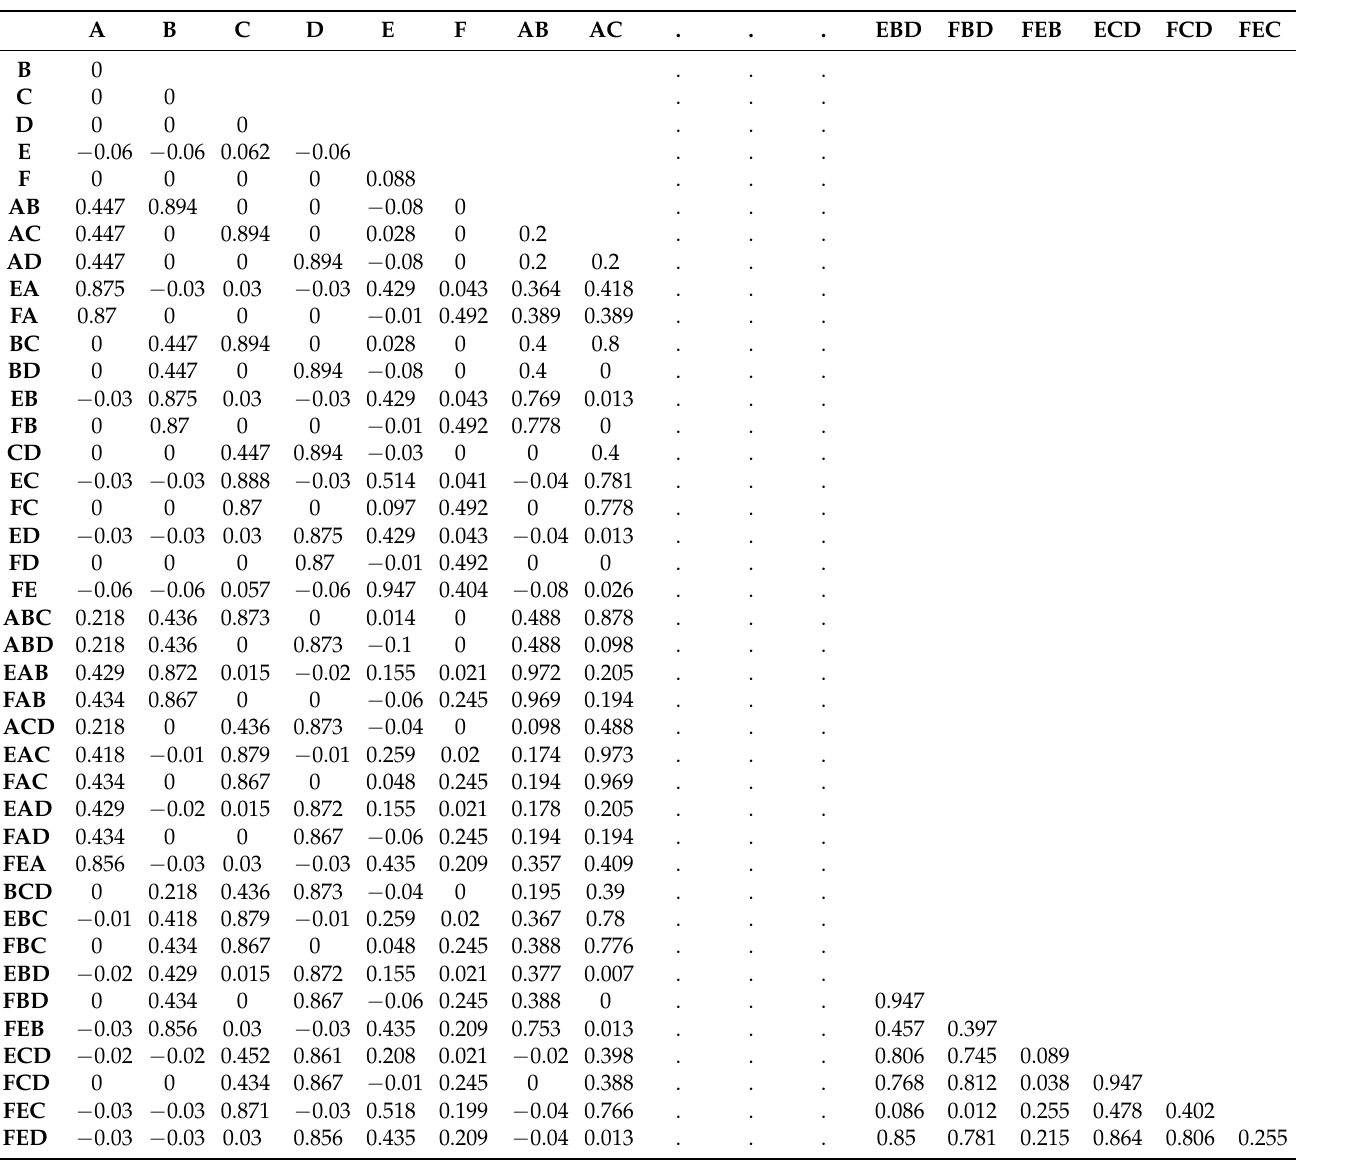
Table 4. Correlation matrix for EA (20, 2 4 3 1 5 1